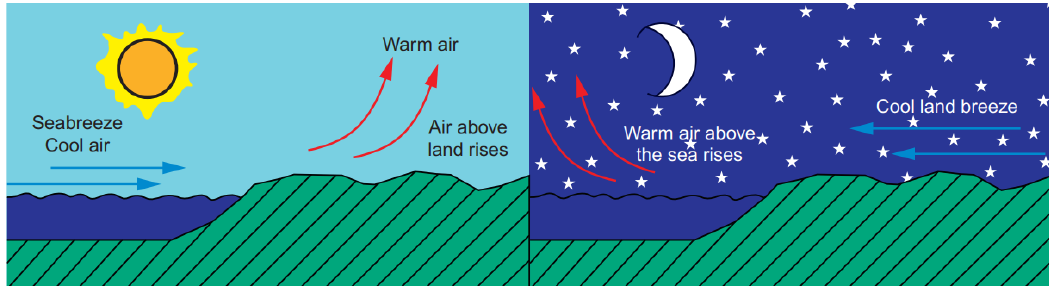
Figure 1. Wind energy at the coastal area. Table 1. Classes of wind power density.